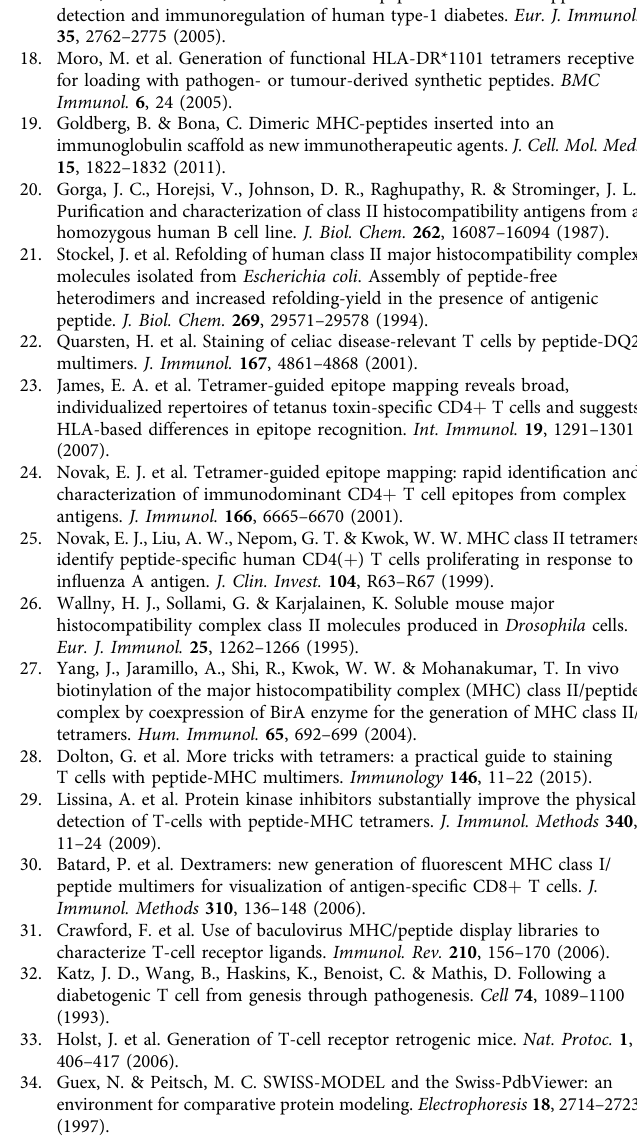
Fig. 9 The KIH Fc affords increased biological potency and stabilizes “ empty ” MHCII. a Representative pMHCII tetramer/eGFP (TCR) FACS dot plots for Jurkat cells expressing hCD4 and an IGRP 13 – 25 /DR3-speci fi c TCR or mCD4 and a BDC2.5mi/IA g7 -speci fi c TCR (negative control). b Representative pMHCII tetramer/eGFP (TCR) dot plots for the Jurkat cells in A, but stained with KIH-based tetramers lacking (left) or carrying a CT (right). c Introduction of a CT into KIH-based human pMHCII does not alter their reactivity with a MHCII conformational epitope-speci fi c mAb, as measured by ELISA. Data correspond to mean ± SEM of triplicates. d Luciferase activity induced by NPs coated with c-jun/c-fos-based ( ‘ conv ’ ), CT IGRP 13 – 25 /DR3 pMHCs vs. NPs coated with non-CT, KIH-based IGRP 13 – 25 /DR3 coated at three different valencies on Jurkat cells co-expressing hCD4, an IGRP 13 – 25 /DR3-speci fi c TCR and NFAT-luciferase. Data correspond to mean ± SEM of triplicates. e Luciferase activity induced by NPs coated with c-jun/c-fos-based/CT ( ‘ conv ’ ) or KIH- based/CT IGRP 13 – 25 /DR3 monomers vs. their non-CT counterparts on Jurkat cells co-expressing hCD4, an IGRP 13 – 25 /DR3-speci fi c TCR and NFAT- luciferase. Data correspond to mean ± SEM of triplicates. f SDS-PAGE of CT leucine-zippered (1) or KIH-based (2) Gliadin 62 – 72 /DQB1*0201/DQA1*0501 monomers. β ME, beta-mercaptoethanol. g Representative pMHCII tetramer/CD4 dot plots for Jurkat cells expressing hCD4 and an IGRP 13 – 25 /DR3-speci fi c (top) or mCD4 and a BDC2.5mi/IA g7 -speci fi c TCR (bottom) stained with c-jun/c-fos-based ( ‘ conv ’ ) IGRP 13 – 25 /DR3 tetramer (peptide-linked; left) or tetramers generated using peptide-loaded empty DR3-KIH monomers (right). h Representative pMHCII tetramer/eGFP (TCR) plots for Jurkat cells expressing hCD4 and PDC-E2 122 – 135 /DRB4-speci fi c TCR (top left), a PDC-E2 249 – 262 /DRB4-speci fi c TCR (top right) or an IGRP 13 – 25 /DR3-speci fi c TCR (bottom; negative control). i Signal ampli fi cation of KIH-based tetramer binding using anti-hFc. Human PBMCs (10 6 ) were spiked with cells from a hIGRP 13 – 25 /DR3-speci fi c T-cell clone (top) or an irrelevant (PPI (76 – 90(88S) /DR4-speci fi c) clone (10 4 ) (bottom). Cells were treated with Dasatinib (right) or left untreated (left) and then stained with PE-labeled tetramers and PE-labeled anti-IgG. Values on the plots correspond to the geometric mean fl uorescence intensity for pMHC tetramer staining. The staining patterns shown in ( a ), ( b ), ( g ), and ( h ) are representative of at least two independent experiments. Source data for panels ( c – e ) are provided as a Source